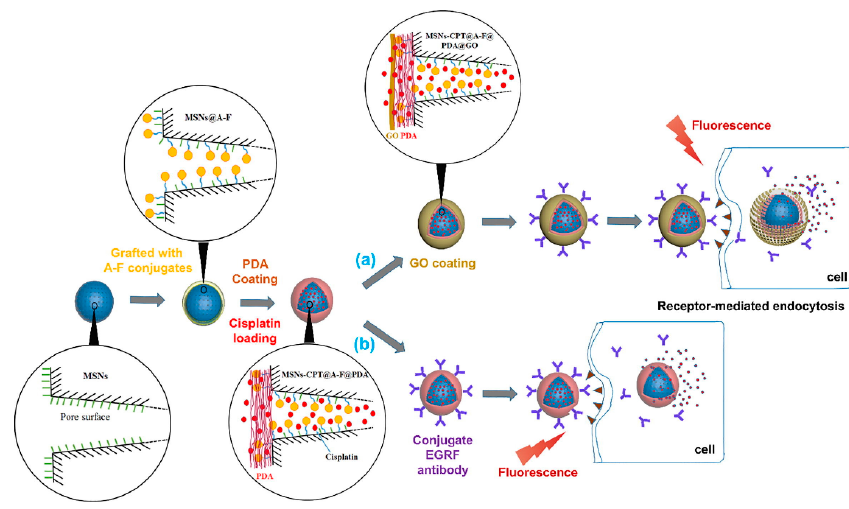
Figure 14. Illustration of preparation of theranostic MSNs ( a ) graphene oxide coated and ( b ) EGRF antibody conjugated without graphene oxide coating, for targeted delivery and imaging in cancer cells. Reproduced with permission from reference [55].